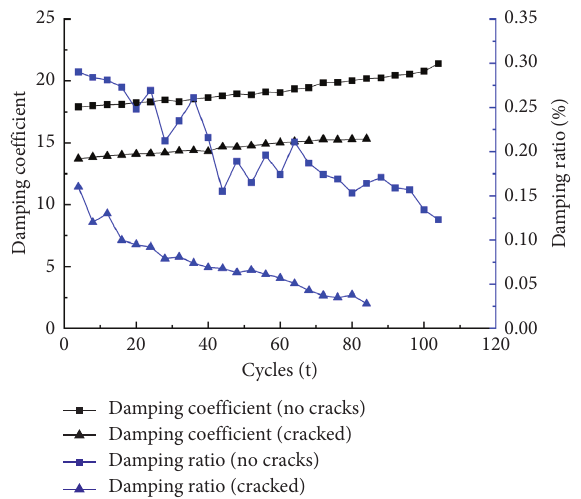
Figure 9: A 6MPa confining pressure on the sandstone damping coefficient, the damping ratio, and the number of